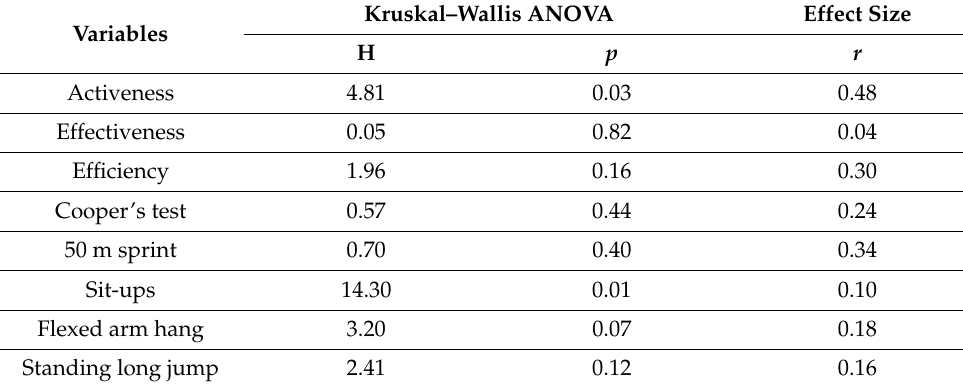
Table 4. Kruskal–Wallis ANOVA between Slovak and Polish